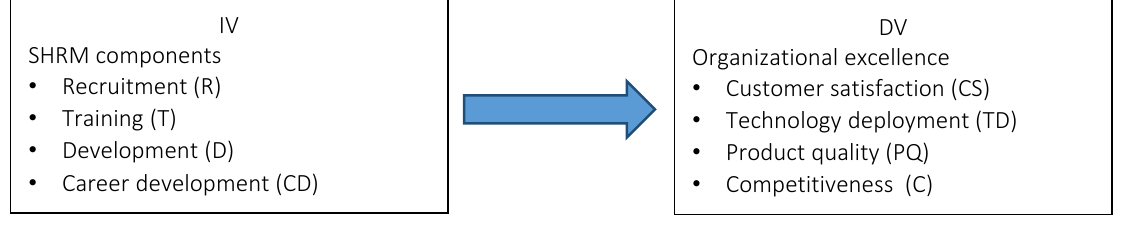
Figure 1. Research